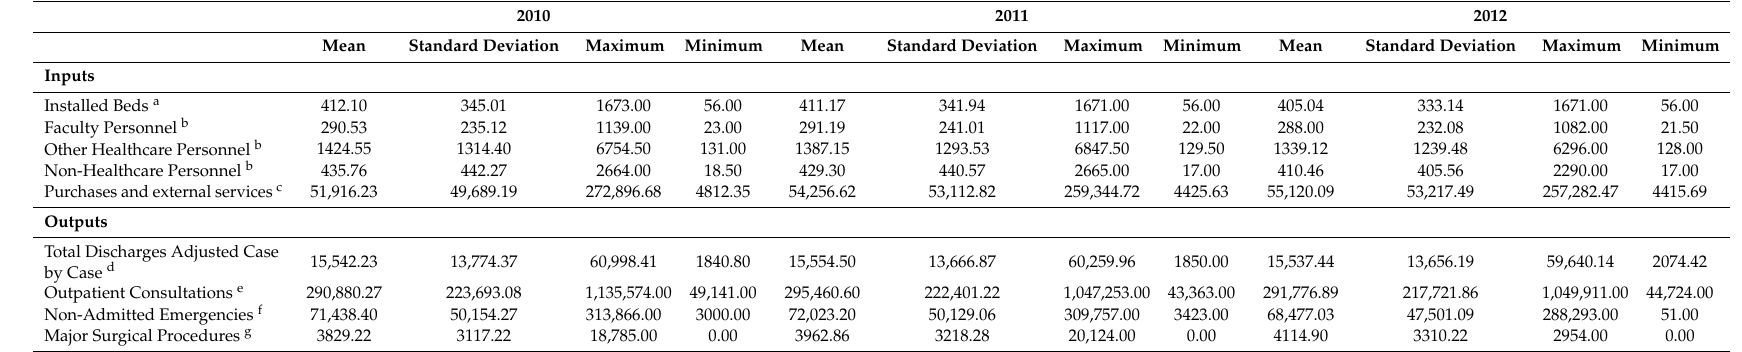
Table 2. Input-output variables of the Spanish National Health Service general hospitals.